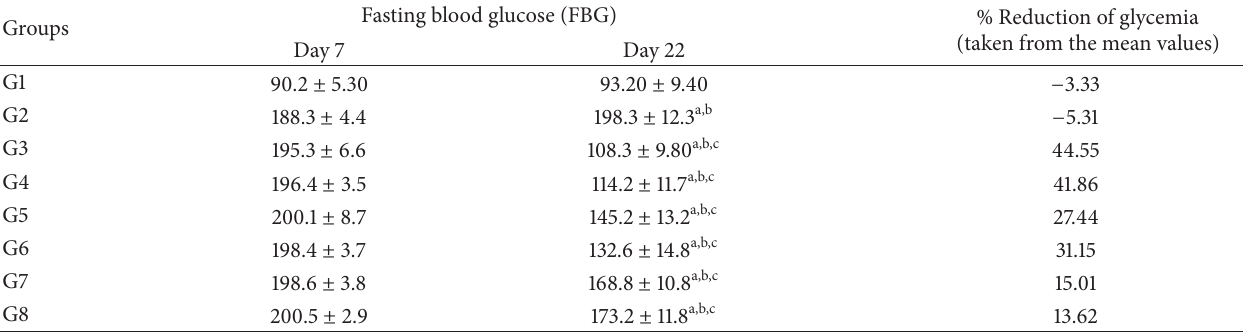
Table 1: Percentage reduction of glycemia by treatment with test compounds in nicotinamide-STZ diabetic rats.